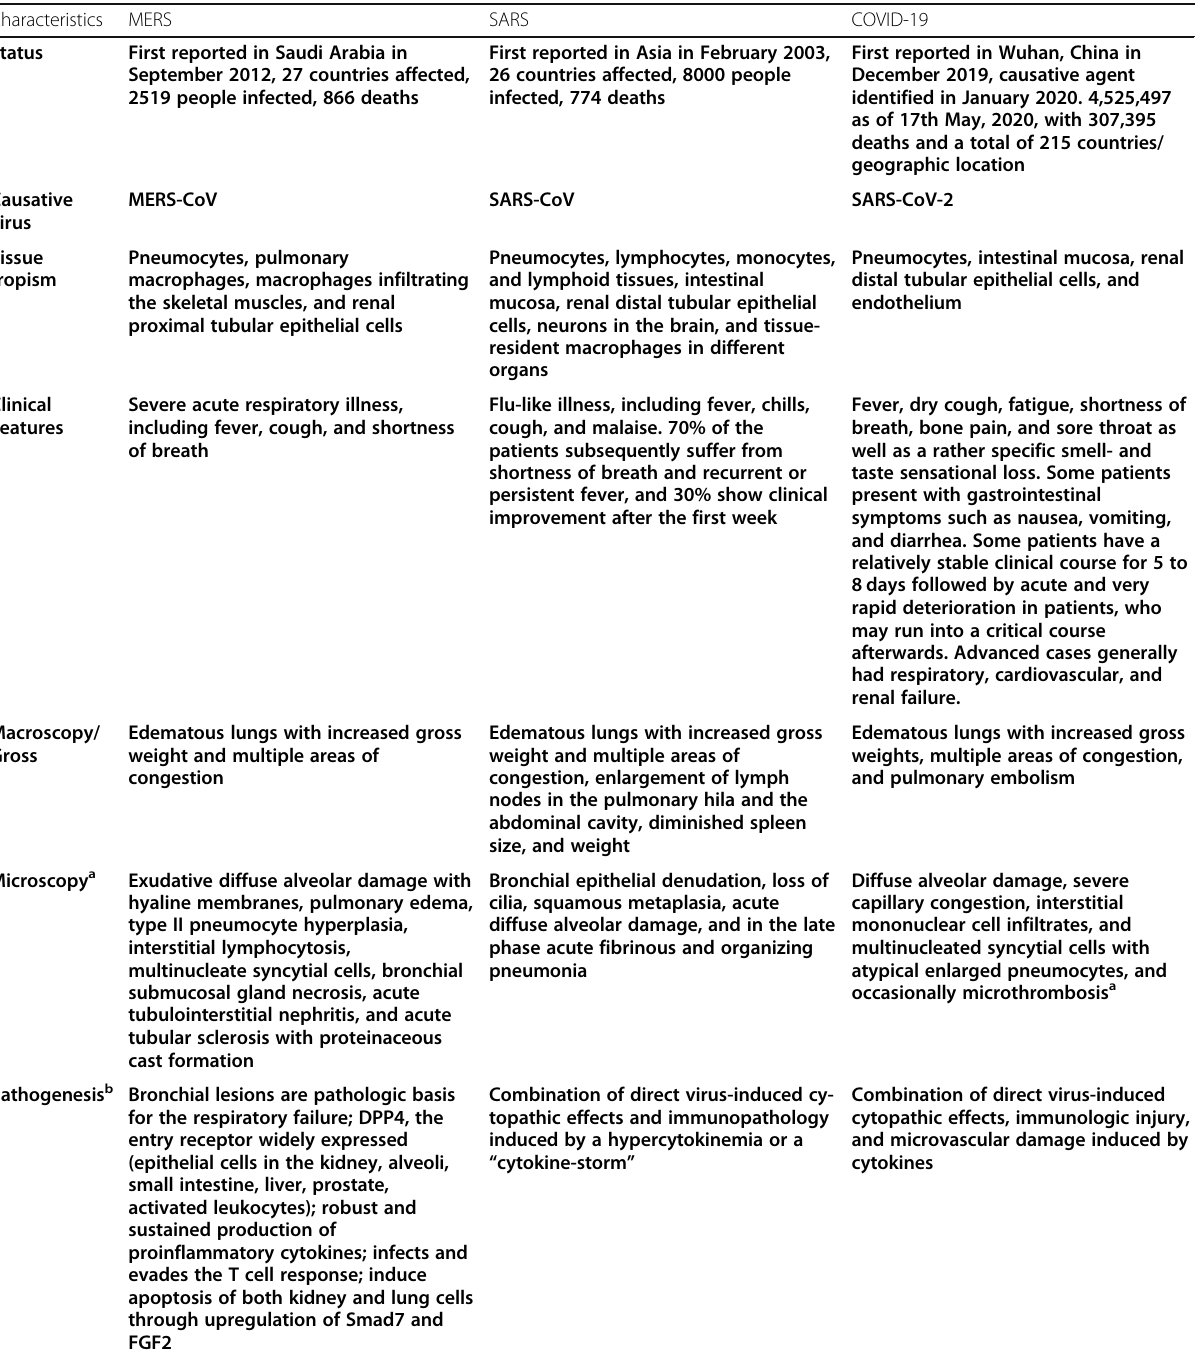
Table 1 Comparison between corona virus-related illnesses those posed significant public health issues